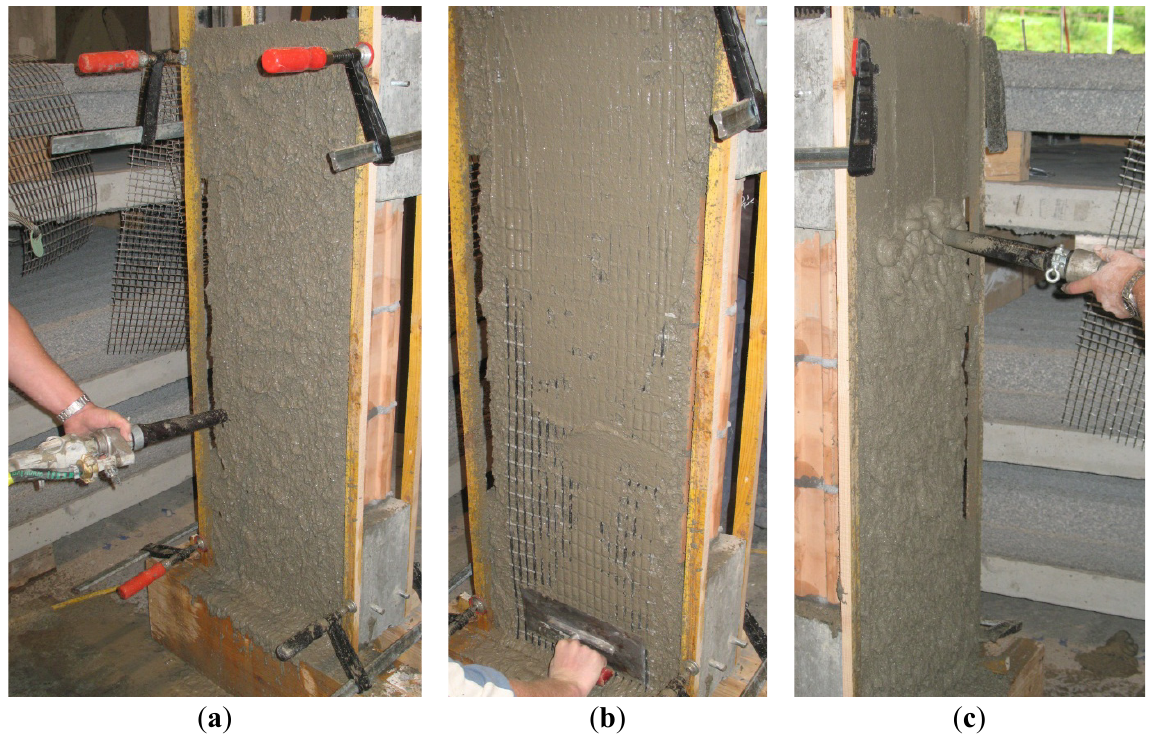
Figure 1. Construction of retrofitted masonry element. ( a ) Application of a layer of